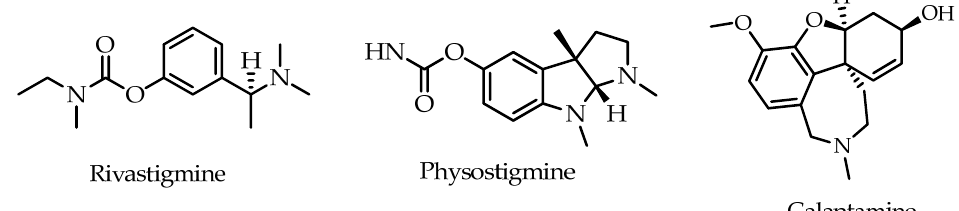
Figure 1. The chemical structures of rivastigmine, physostigmine, and